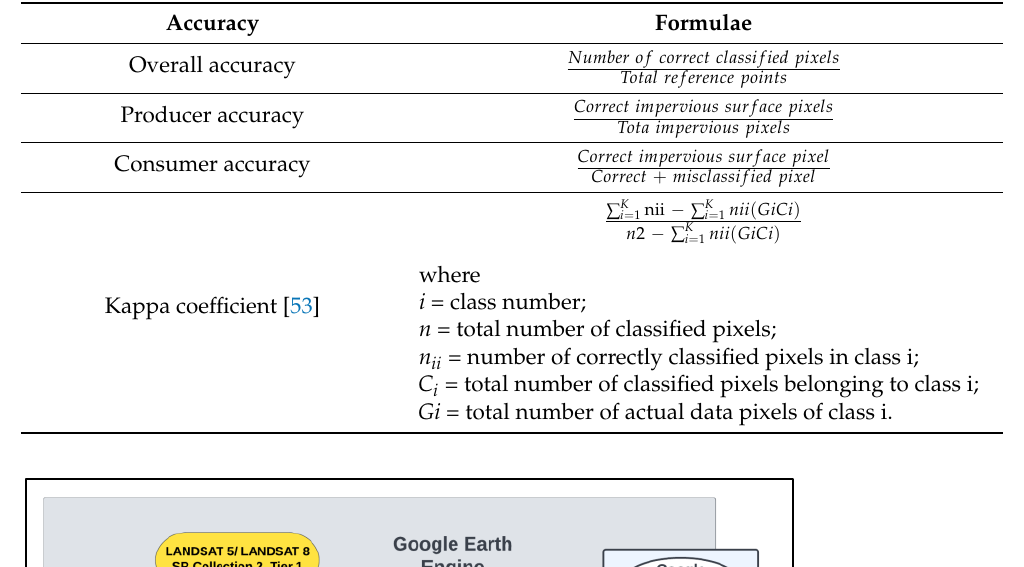
Table 4. Formulae for calculating accuracy metrics.